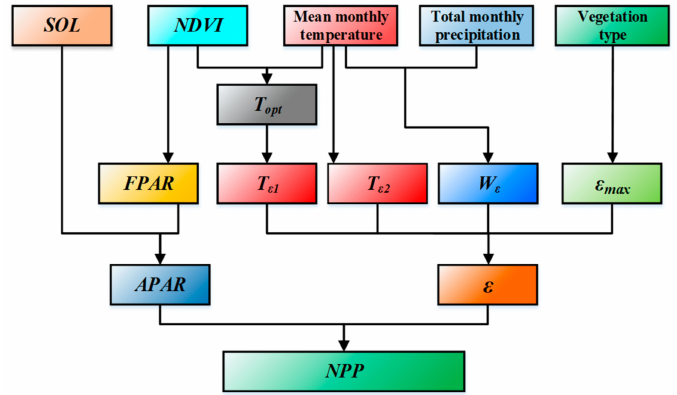
Figure 2. Framework of the Carnegie-Ames-Stanford approach (CASA) estimation